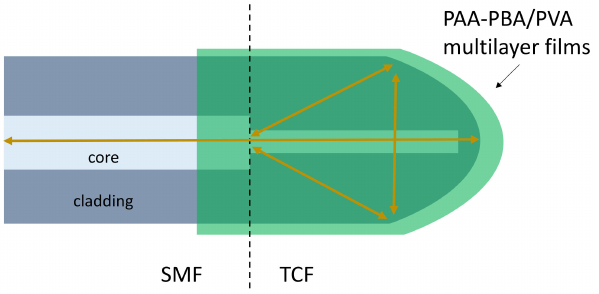
Figure 9. Schematic diagram of the thin-core fiber (TCF) coated with PAA-PBA/PVA films, and the TCF has a rounded tip. A SMF is spliced with the